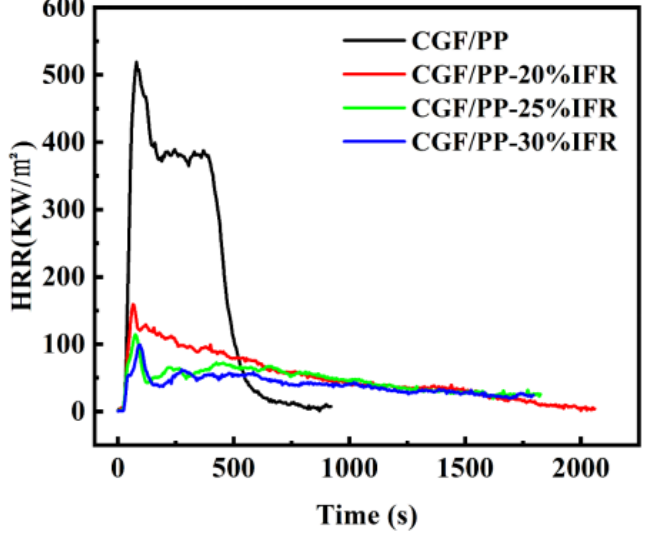
Figure 5. Heat release rate curves of composites with different IFR content. Table 4. Combustion parameters of samples from cone calorimeter